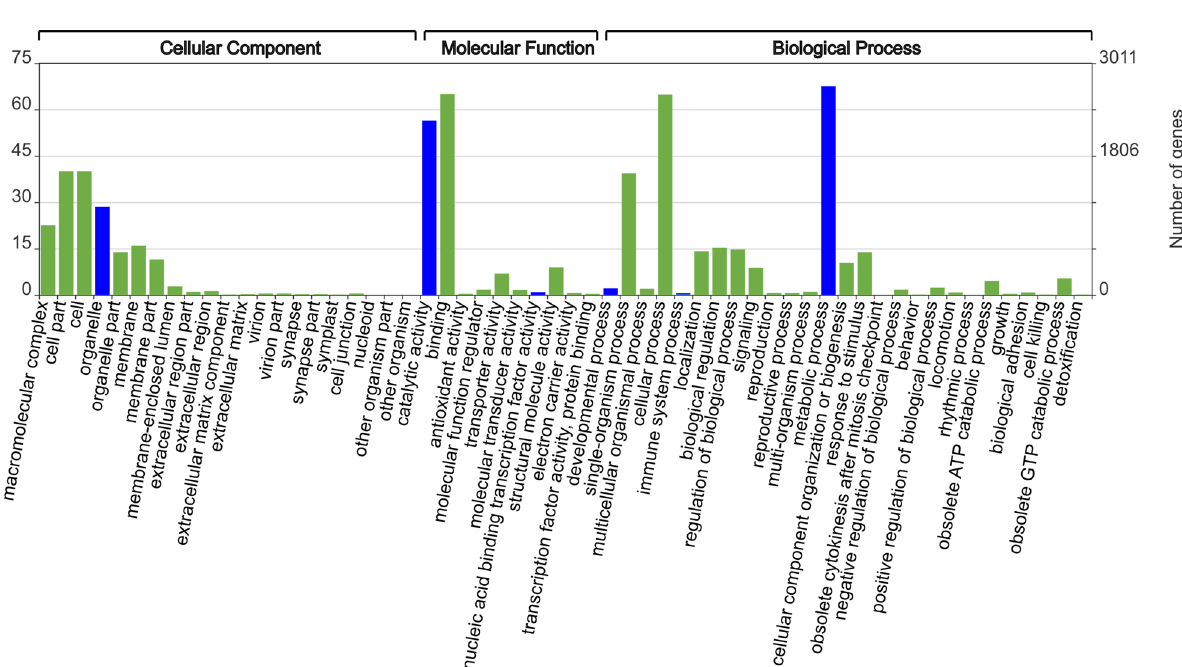
Figure 2. Schematic diagram of the protein annotation process based on the intersect transcriptome from spore sacs and fish kidney tissues. Protein predictions were submitted to the signalP, TMHMM, HMMER and PFam databases and BLAST analysis. Swiss-Prot matches were mapped to Gene Ontology, EggNOG and KEGG classes. Parasite contigs associated with virulence, metabolism, and development were selected and host-specific expression profiles characterised.